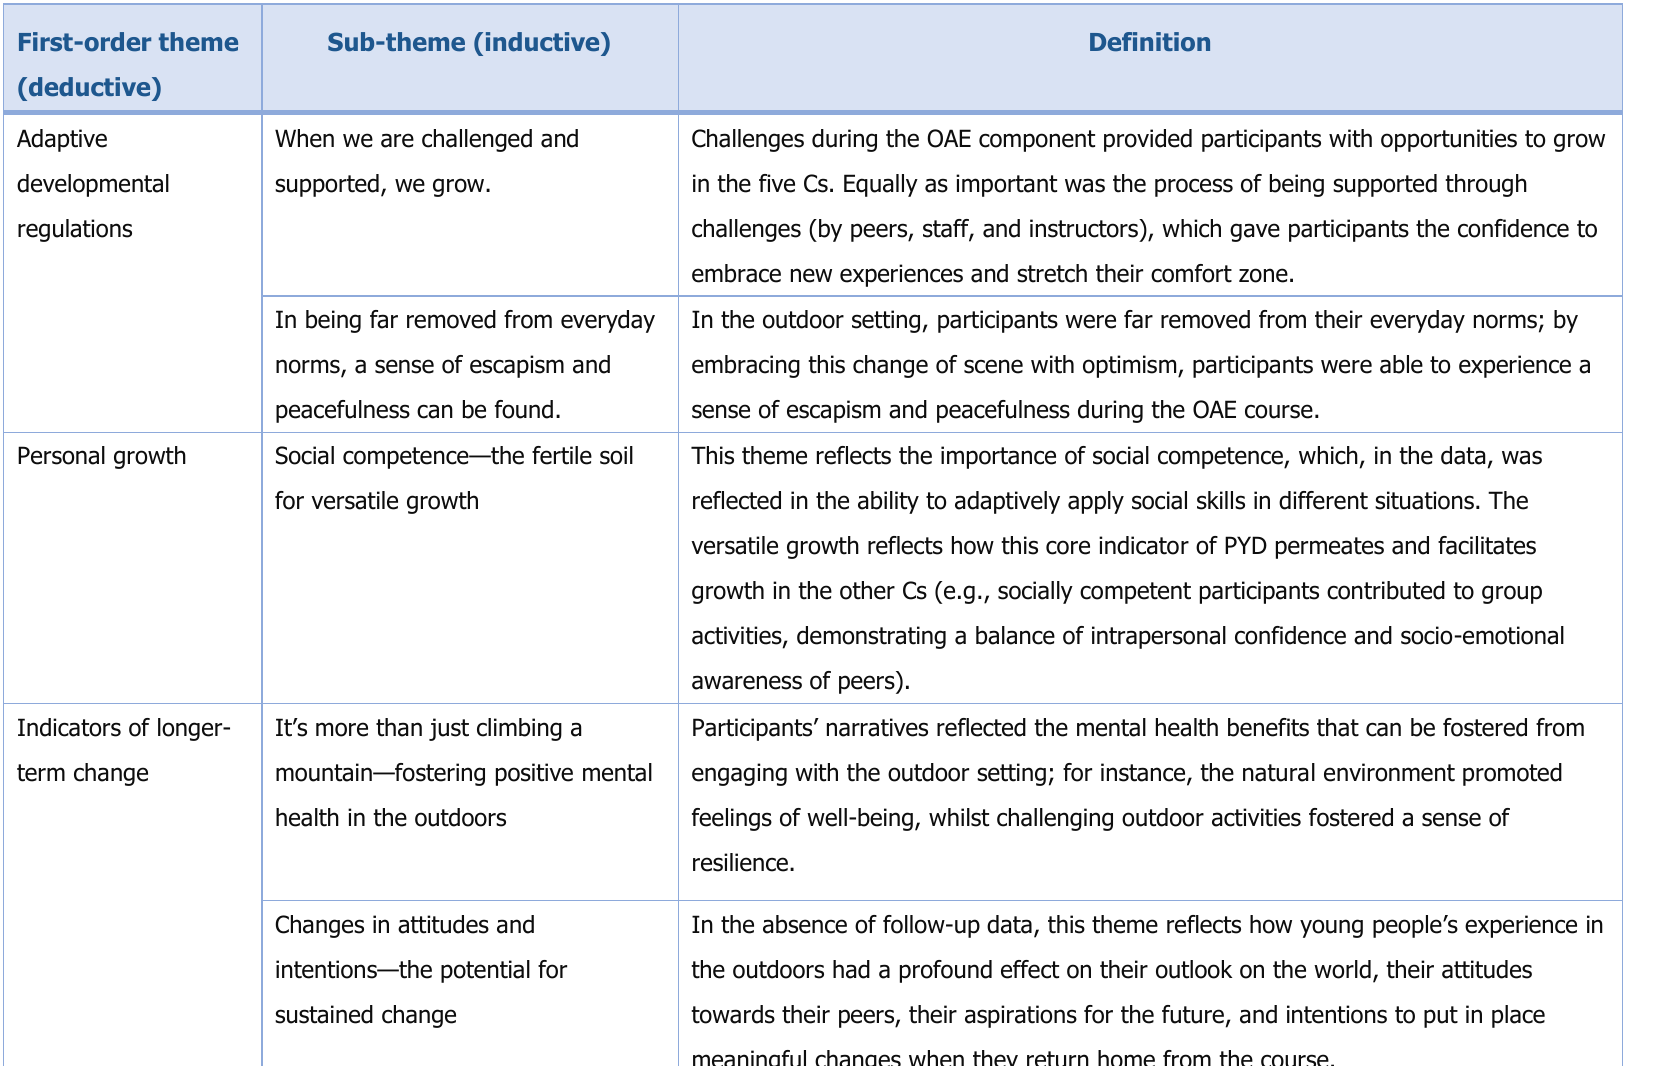
Table 2. Definitions of Data-Driven